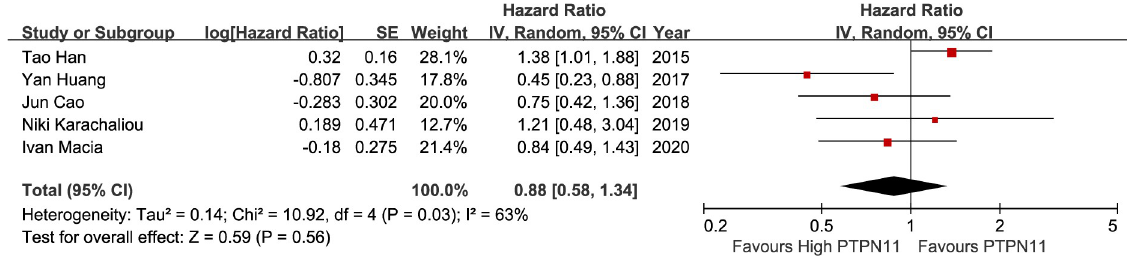
Fig 3. A forest plot for the association between SHP2 expression levels with DFS.